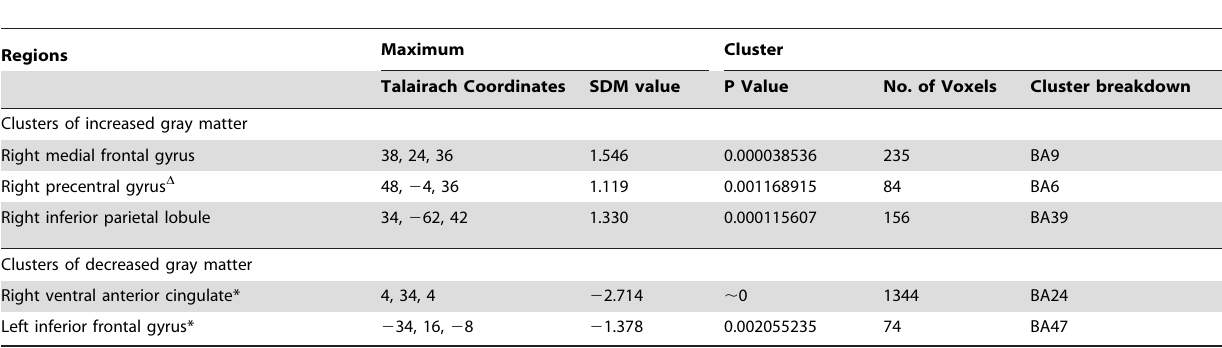
Table 5. Regions With Significant Differences In Gray Matter Volumes Between Adult Patients With Anxiety Disorders Comorbid Depression And Healthy